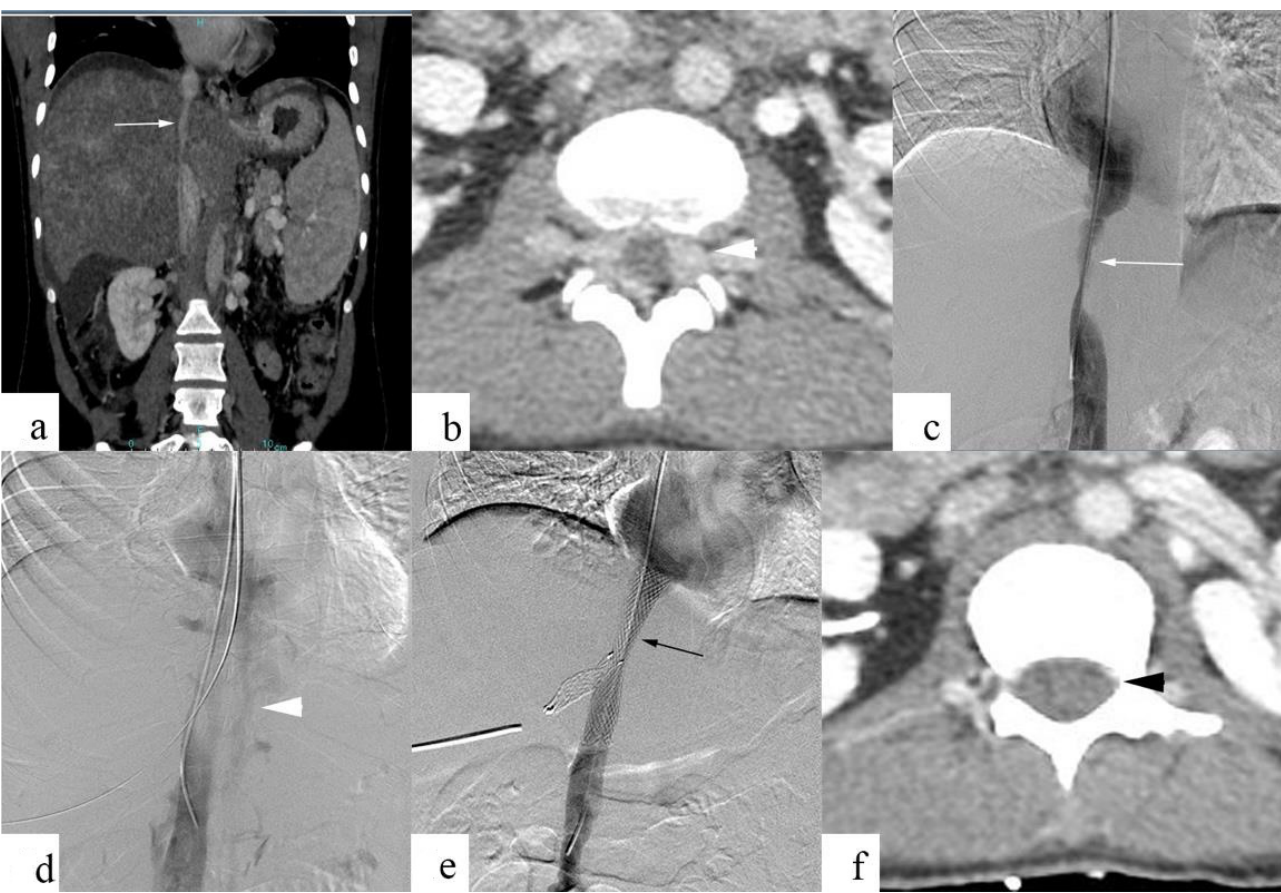
Figure 4. Chronic IVC stenosis in a 32-year-old male patient with Budd – Chiari syndrome and back pain. Contrast-enhanced CT and digital subtraction angiographic images show chronic IVC stenosis involving intrahepatic IVC (4a, 4c; white arrow), and paravertebral venous plexus and epidural venous plexus enlargement (4b, 4d; white arrowhead). Balloon angioplasty, primary stenting, and hepatic venous obstruction (4e; black arrow) were performed for IVC, following which the resolution of EVEs (4f; black arrowhead) was noted, along with back pain relief.